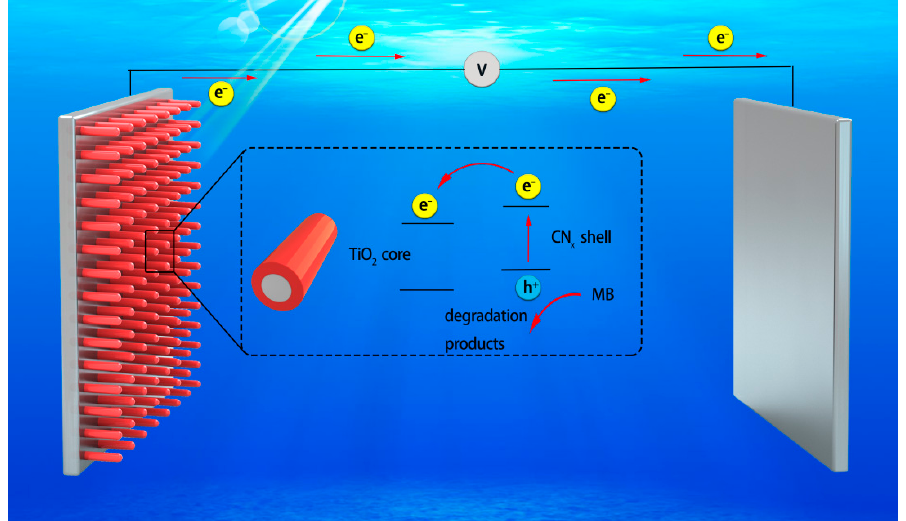
Figure 6. Charge transfer mechanism of CN x /TiO 2 core-shell nanowire arrays.